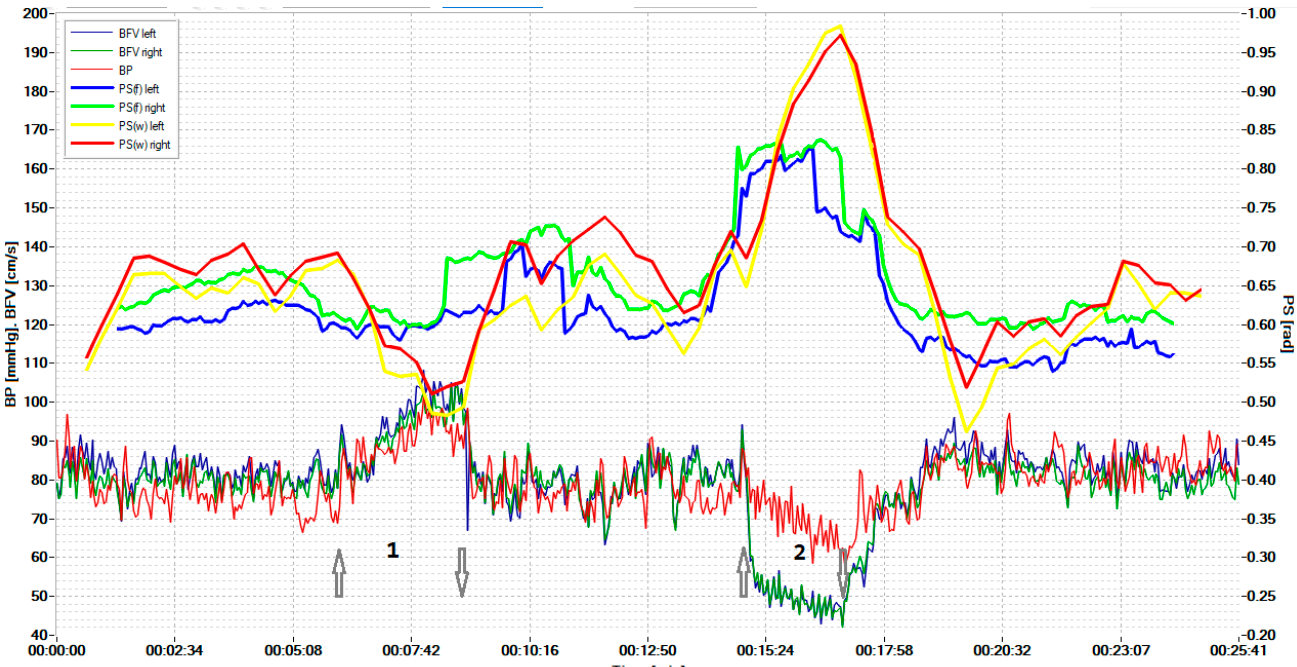
Figure 4. Simultaneous monitoring of parameters of the cerebral, systemic hemodynamics, and the cerebral autoregulation state in a 19-year-old healthy volunteer. The arrow pointing up indicates the beginning of the hypercapnic test (1), while the arrow pointing down indicates its end. Similarly directed arrows indicate the beginning and end of the hypocapnic test (2).